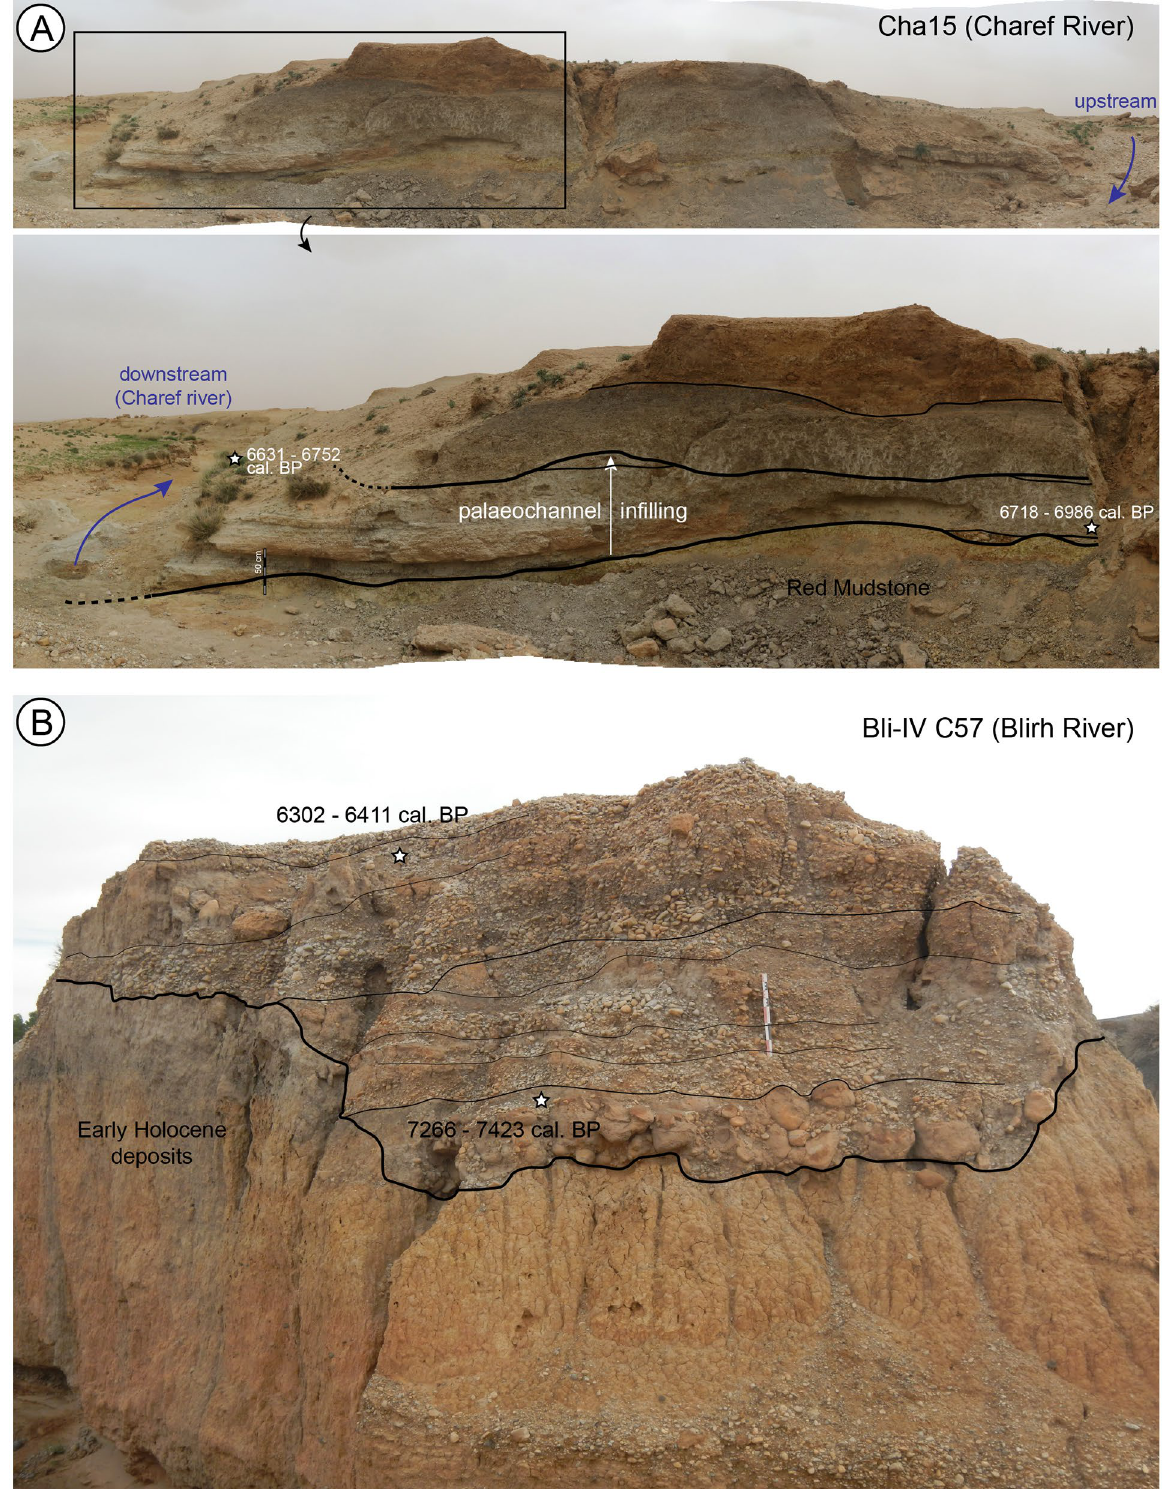
Figure 5. Views of the two other partially eroded palaeochannels identified in the Moulouya’s upstream basins. ( A ) The Cha15 outcrop located 1.5 km upstream of Cha07, on a small tributary 10 km long of the Charef